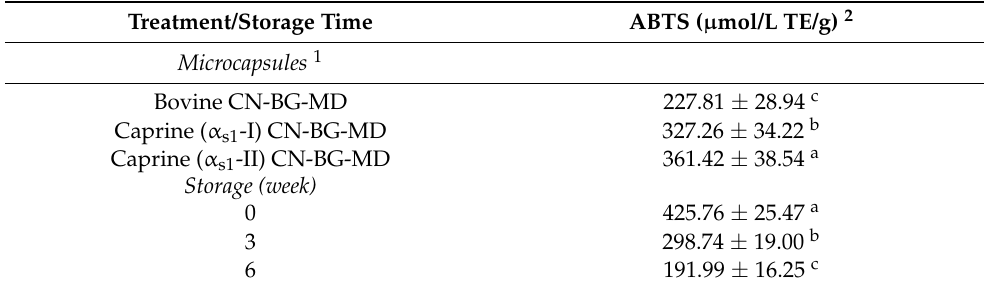
Table 4. Antioxidant activity of lutein in the lutein microcapsules during storage for 6 weeks at 20 ◦ C and 32% relative humidity by the ABTS free radical method.